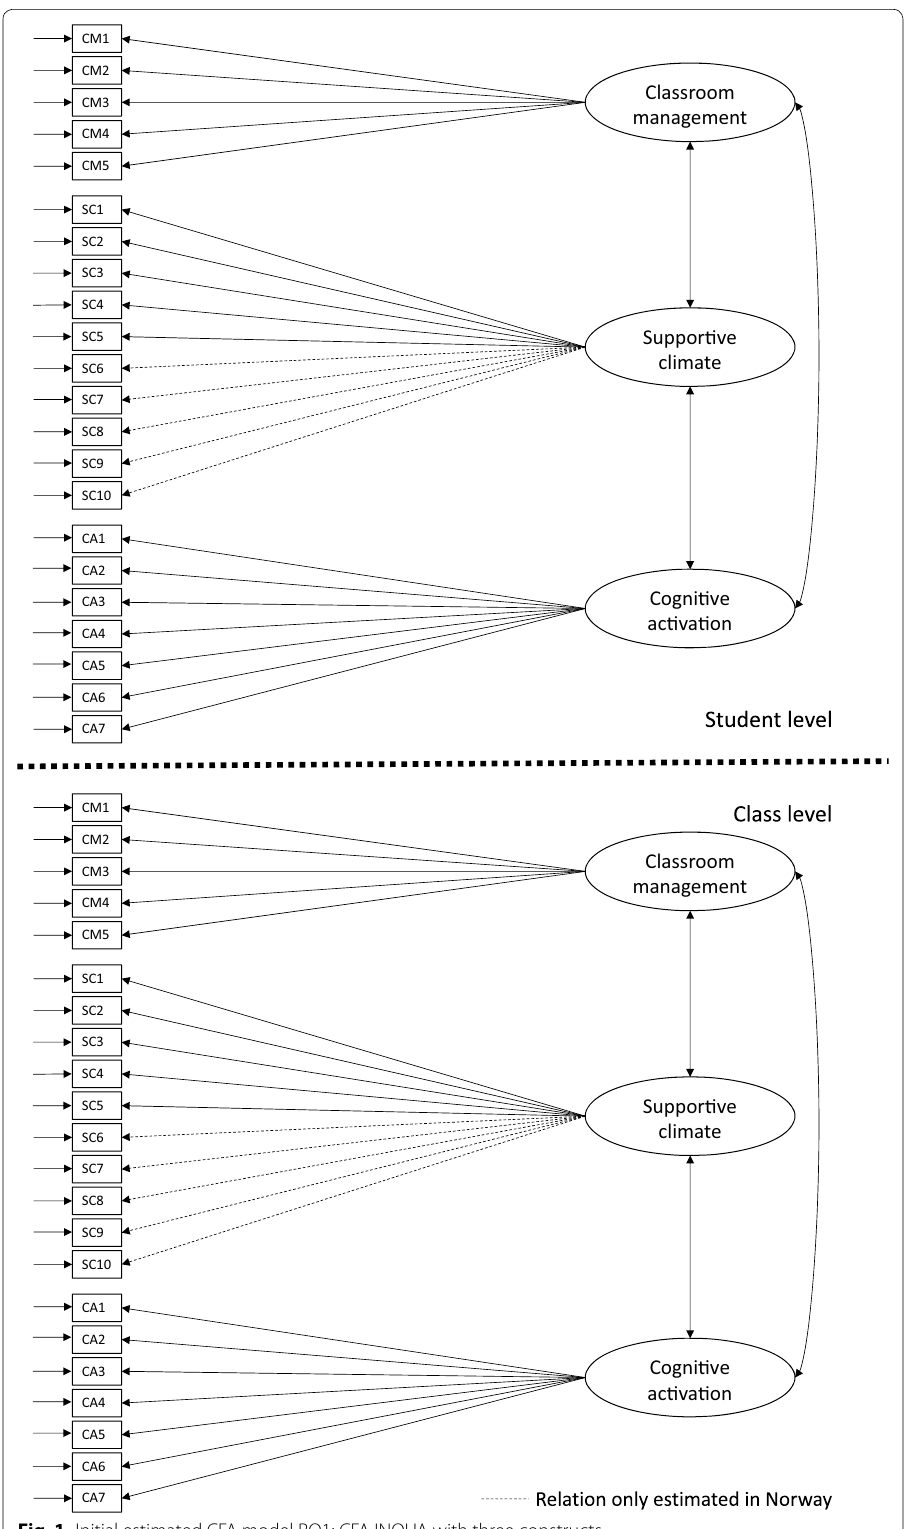
Fig. 1 Initial estimated CFA model RQ1: CFA INQUA with three